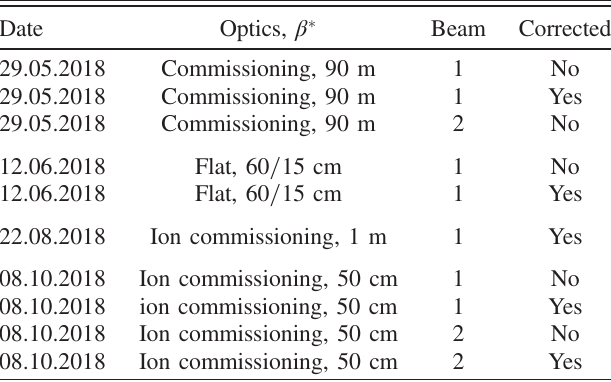
TABLE II. List of measurements where IF has been used during online data analysis in 2018. Beam 1 appears more often in the statistics just due to the human intervention in the optics analysis and subjective decision about the need for additional cleaning with IF.